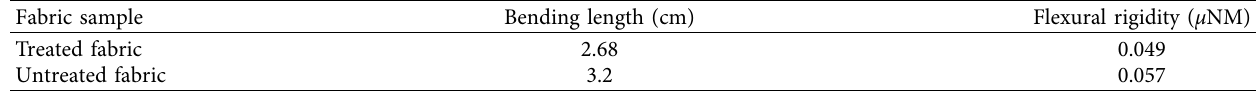
Table 7: Stiffness properties of untreated and treated